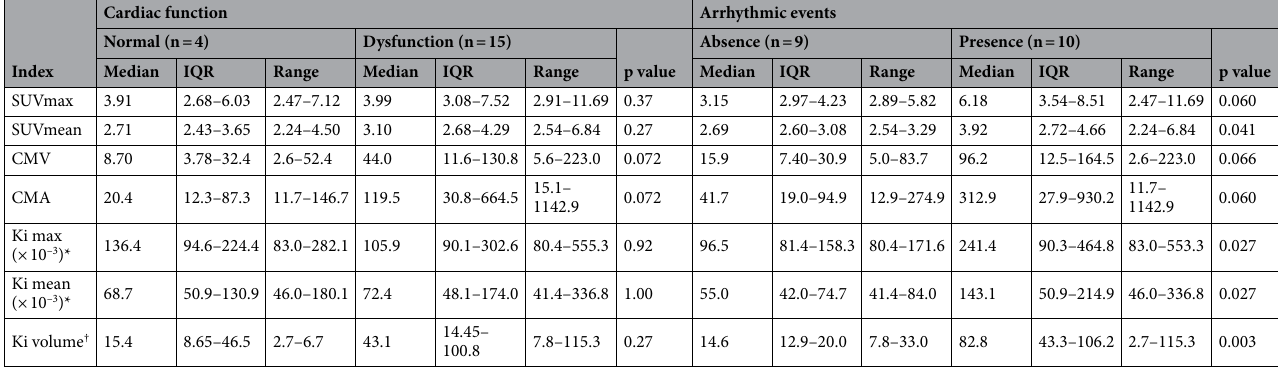
Table 2. Relationships between quantitative SUV or Ki parameters and clinical events in 19 18 F-FDG